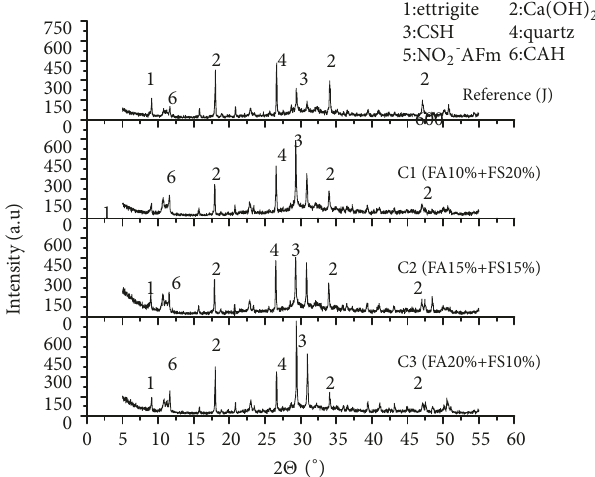
Figure 7: The X-ray diffraction pattern of the samples compounded different proportion fly ash and slag and reference